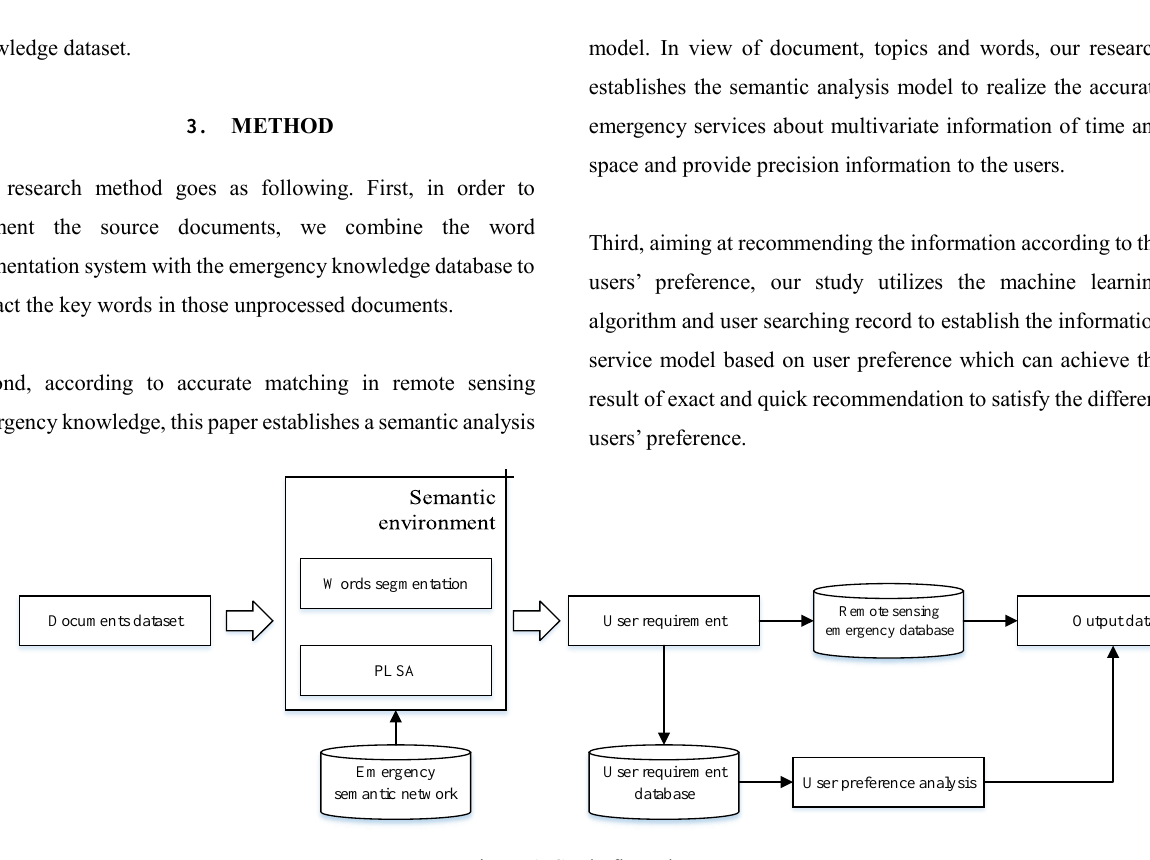
Figure 1. Study flow